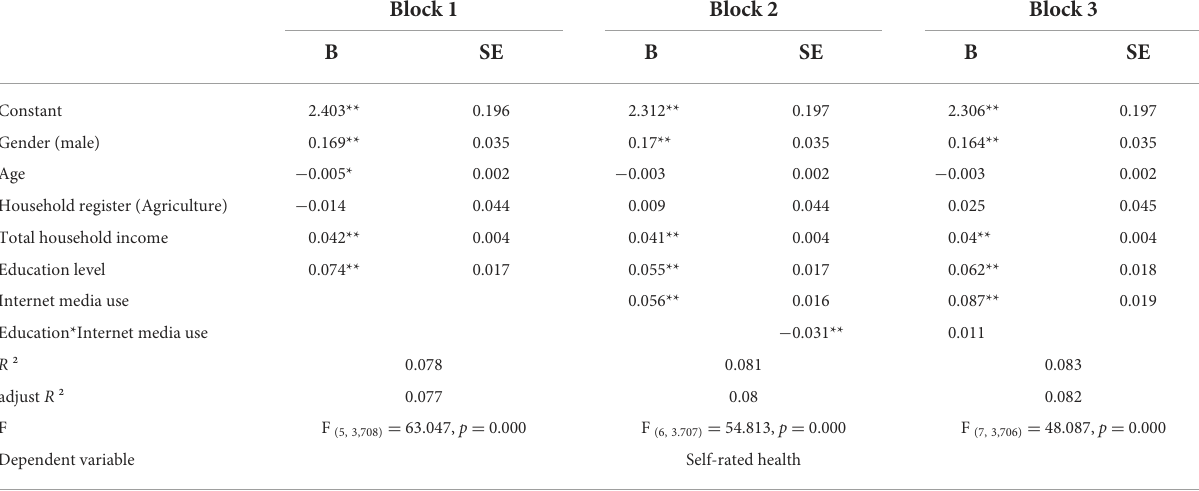
TABLE 9 Results of hierarchical regression analysis